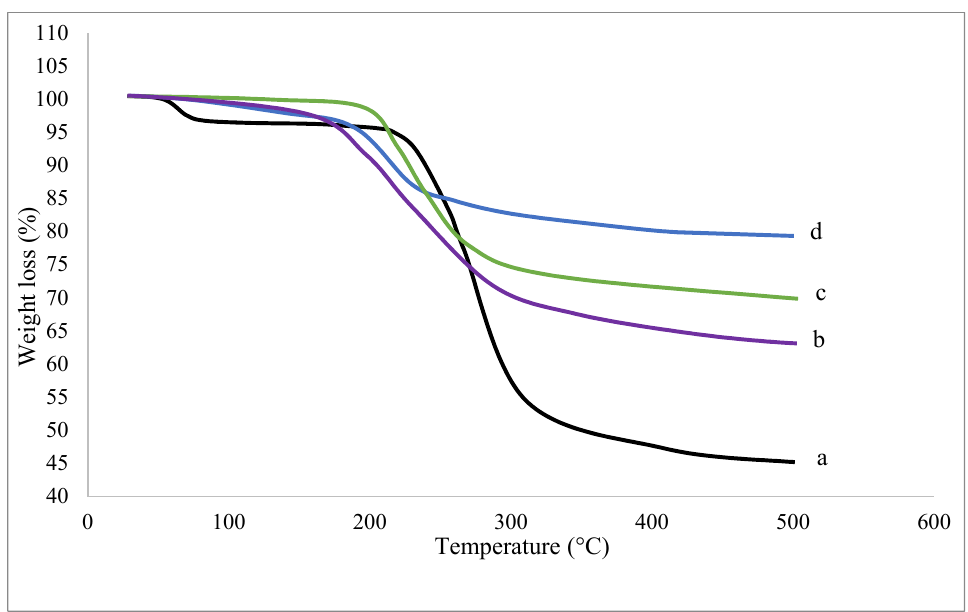
Figure 4. TGA of various CS-g-(DAA-IA) copolymers (%G: b = 49.1%, c = 60.65%, d = 72.05%) as compared to CS (a).